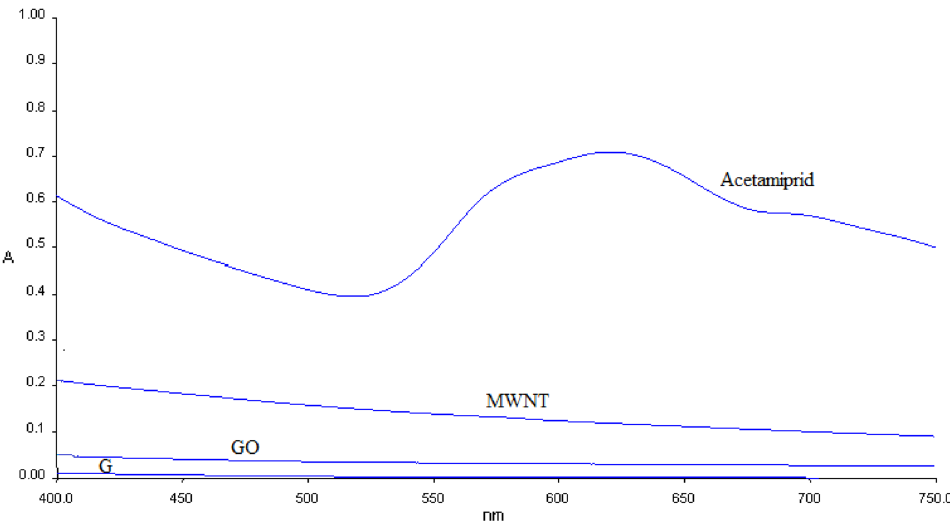
Figure 4. The UV spectrum of acetamiprid adsorption on graphene oxide, multi-walled nanotubes, and